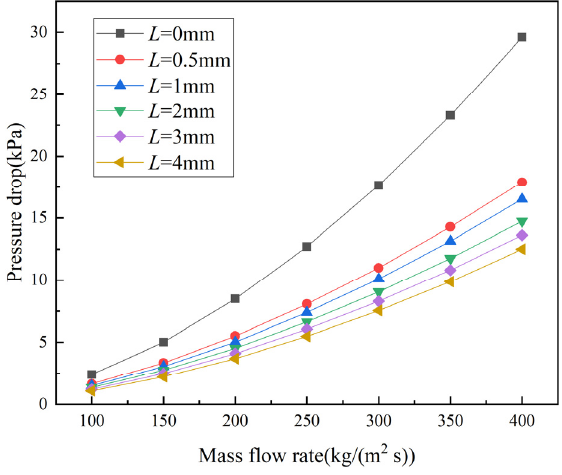
Figure 5. Fanning friction factor values of PCHEs at different mass flow rates for different offset distances of inserted straight sections.